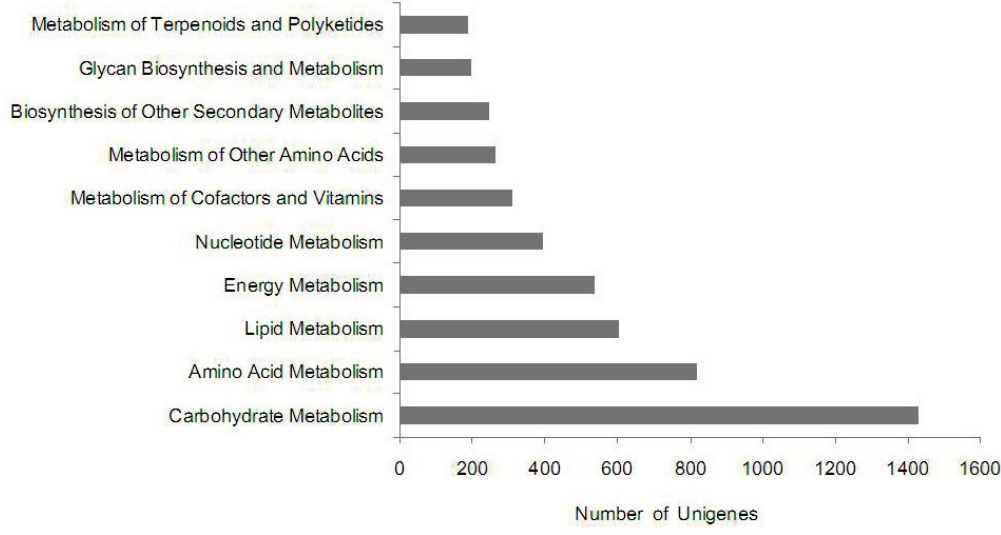
Figure 4. Pathway assignment based on the Kyoto Encyclopedia of Genes and Genomes